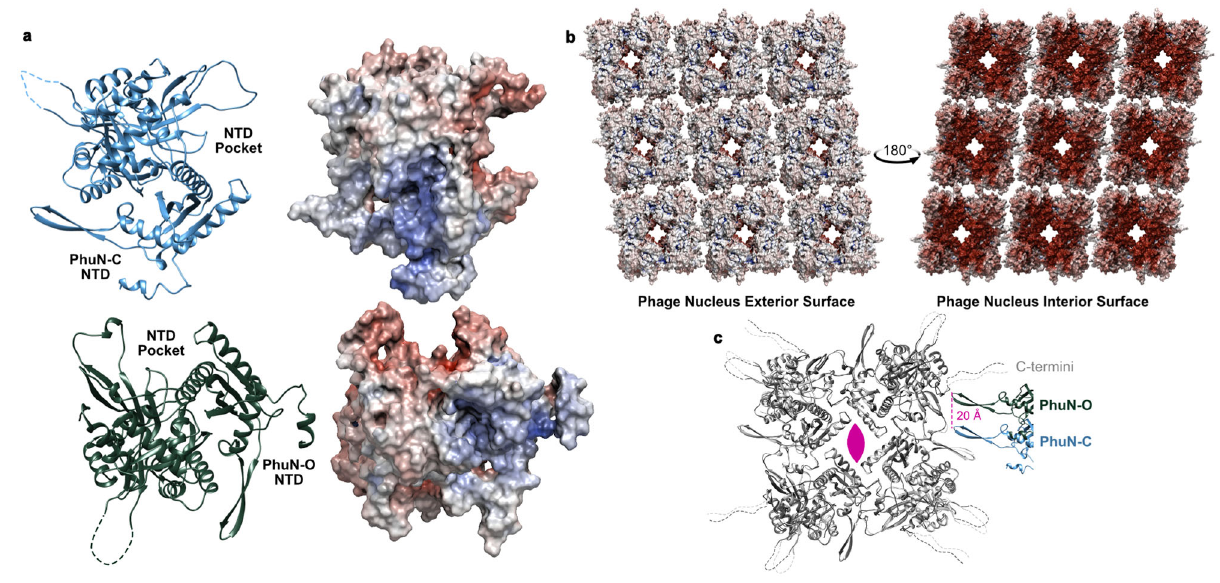
Fig.3|AcloserlookatPhuNinteractionsandelectrostaticpotential.a Surfaces of PhuN-C (top) and PhuN-O (bottom) colored by electrostatic potential with their corresponding models on the left. b Electrostatic potential coloration of the interior and exterior phage nucleus surfaces created by PhuN assemblies. Surface charge calculation was done at pH 6.5 and includes the C-terminal tail tips. Red